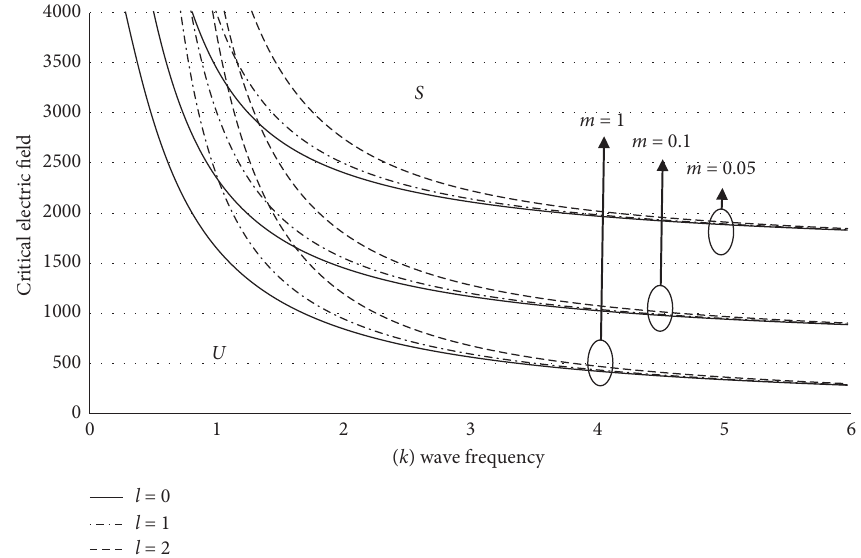
with k for different values of the electrical conductivites α 0